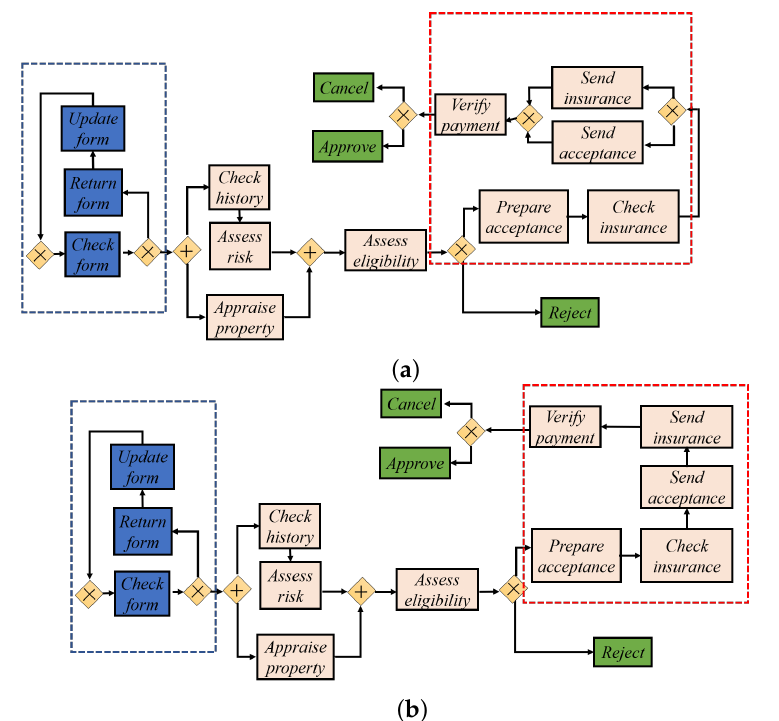
Figure 3. The base model and one of its alternative versions. ( a ) base model; ( b ) altered model (‘cf’).